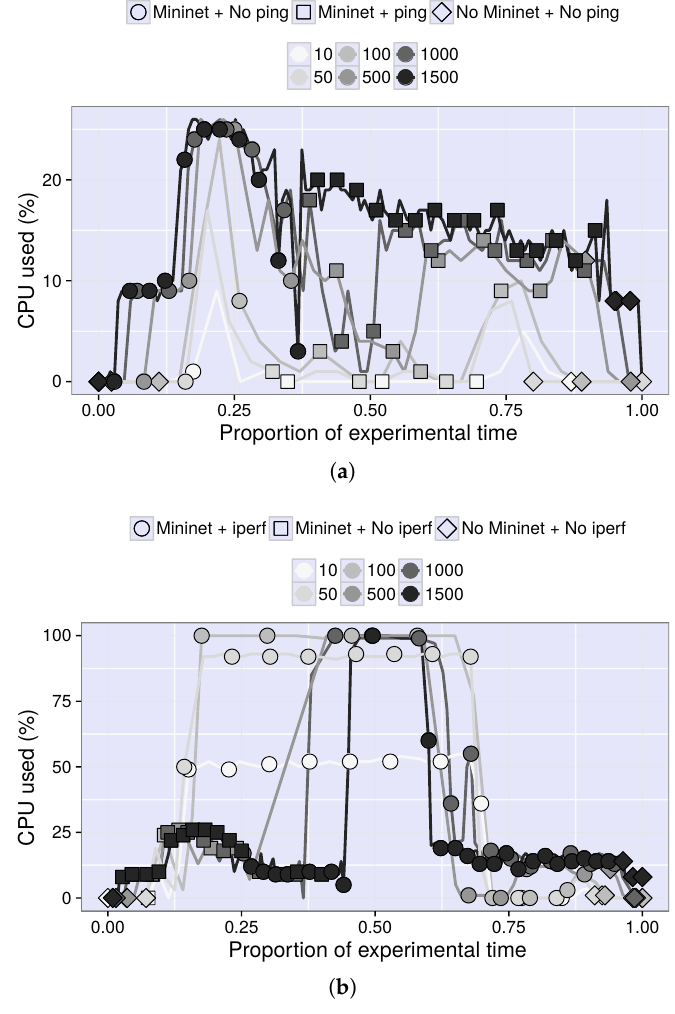
Figure 3. Percentage of used CPU in terms of number of hosts, 10 switches. ( a ) Low network activity; ( b ) high network